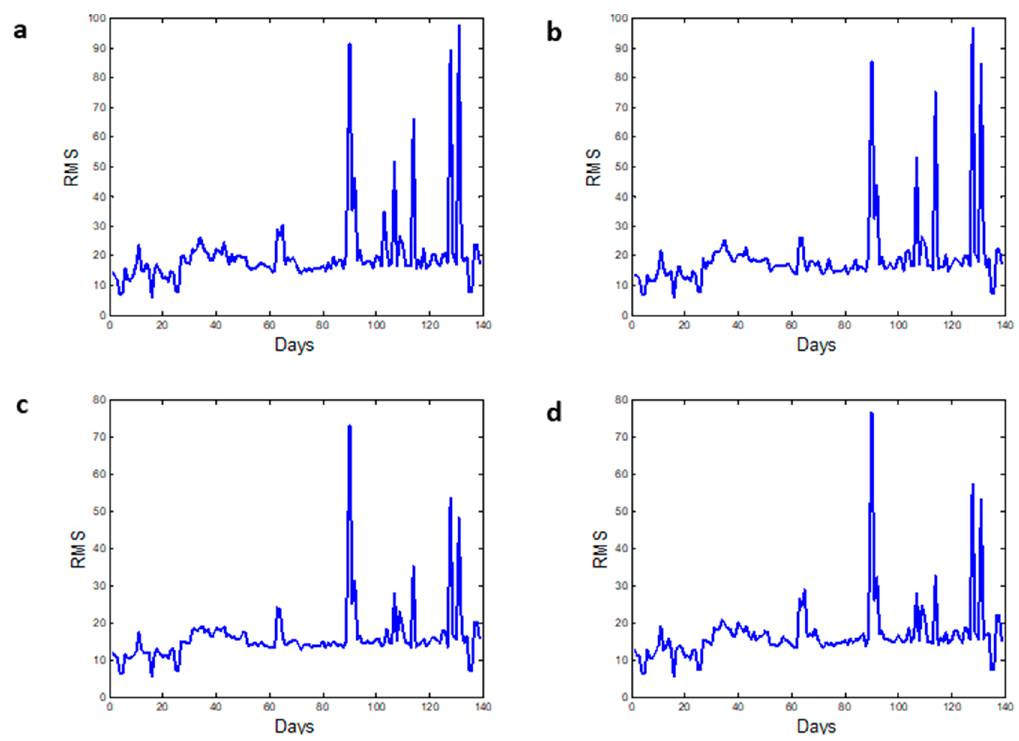
Figure 10. RMS feature calculated from MM operators for 0.9 T (T = 1/BSF): ( a ) erosion; ( b ) dilation; ( c ) closing and ( d ) opening.